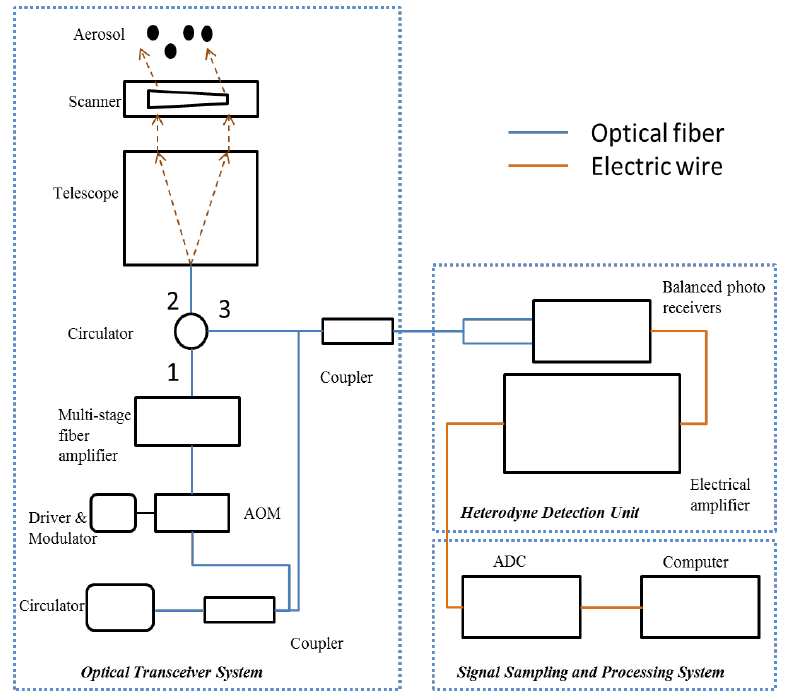
Figure 1. Schematic of the CWL. Table 1. Main technical parameters of the CWL.